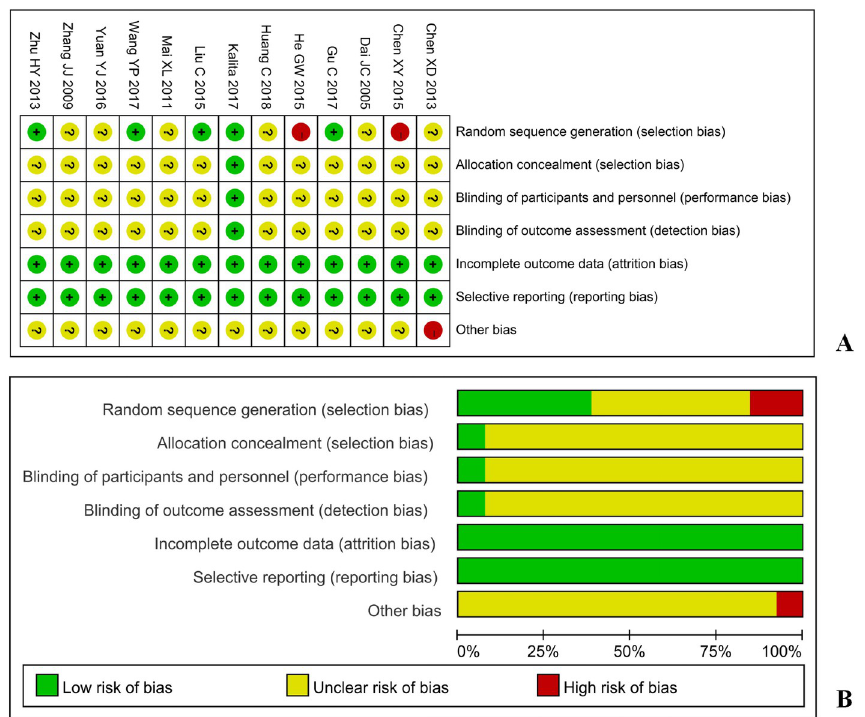
Fig 2. Risk of bias graph. A: Risk of bias summary; B: Risk of bias graph.